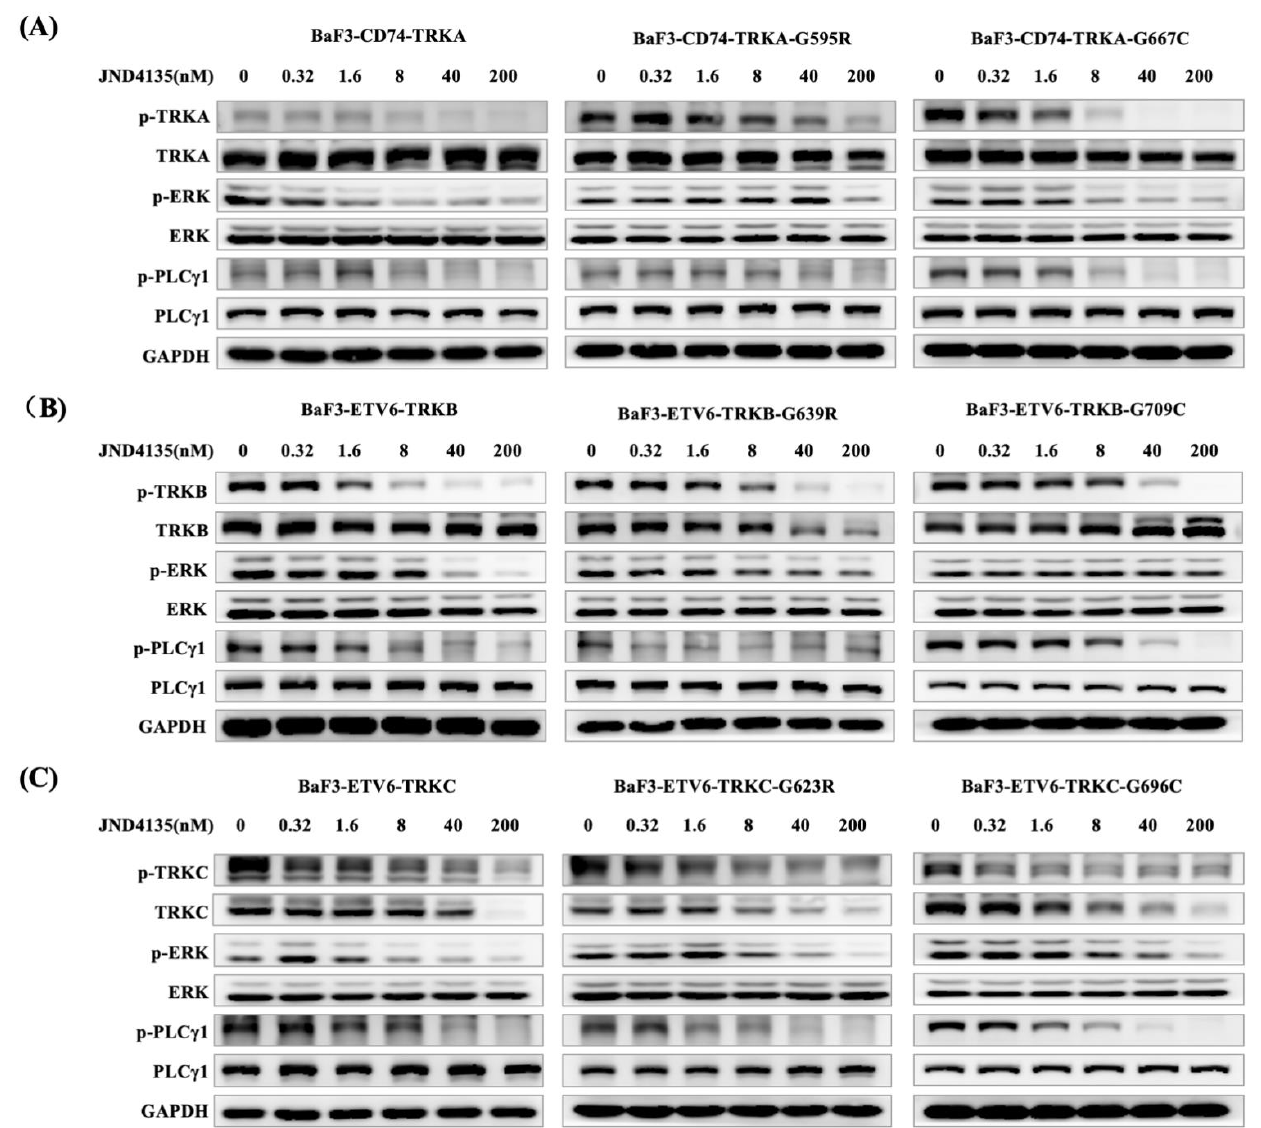
Figure 2. JND4135 suppresses TRK signaling pathway in TRK fusion-driven BaF3 cell lines. ( A ) JND4135 inhibited the TRKA signaling pathways in BaF3-CD74-TRKA, BaF3-CD74-TRKA-G595R and BaF3-CD74-TRKA-G667C cells. ( B ) JND4135 inhibited the TRKB signaling pathways in BaF3- ETV6-TRKB, BaF3-ETV6-TRKB-G639R and BaF3-ETV6-TRKB-G709C cells. ( C ) JND4135 inhibited the TRKC signaling pathways in BaF3-ETV6-TRKC, BaF3-ETV6-TRKC-G623R and BaF3-ETV6-TRKC- G696C cells. Cells were pretreated with 0–200 nmol/L of JND4135 for 6 h, then harvested and lysed. Cell lysates were separated by sodium dodecyl sulfate-polyacrylamide gel electrophoresis (SDS-PAGE) and analyzed by Western blot for p-TRK, p-PLC γ 1 and p-Erk. GAPDH was used as a loading